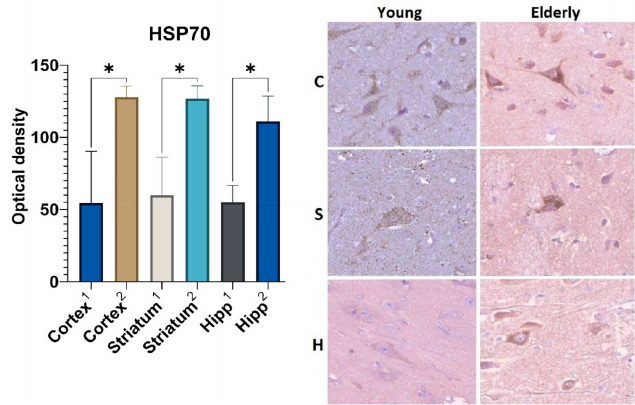
Figure 2. Results of HSP70 immunohistochemical staining: 1—young group, 2—elderly group; C—cortex, S—corpus striatum, H—hippocampus. *—differences are statistically significant ( p < 0.05). Magnification 400 × .